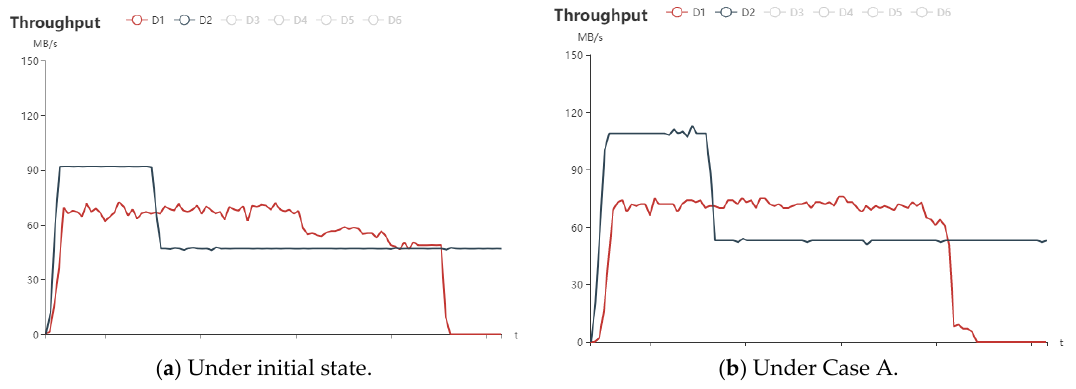
Figure 10. The real-time throughput monitoring curves of 𝐷 1 and 𝐷 2 .